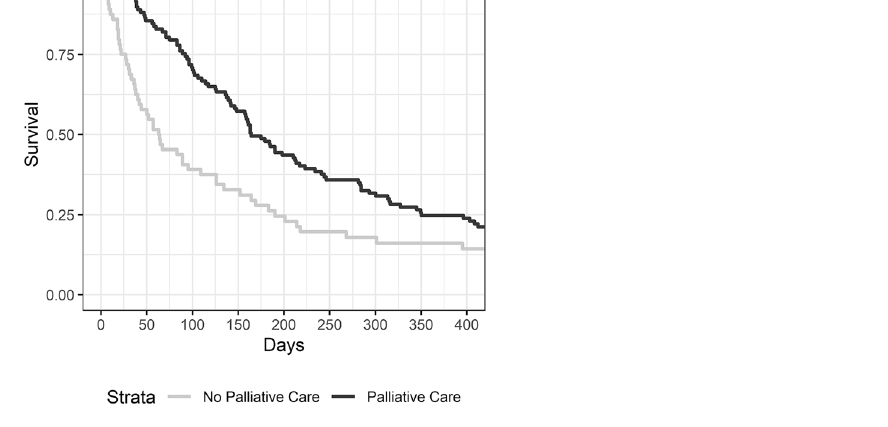
Figure 1. Kaplan Meier survival curves for patients with metastatic hepatopancreaticobiliary and gastrointestinal cancers referred to palliative care services at a single institution,